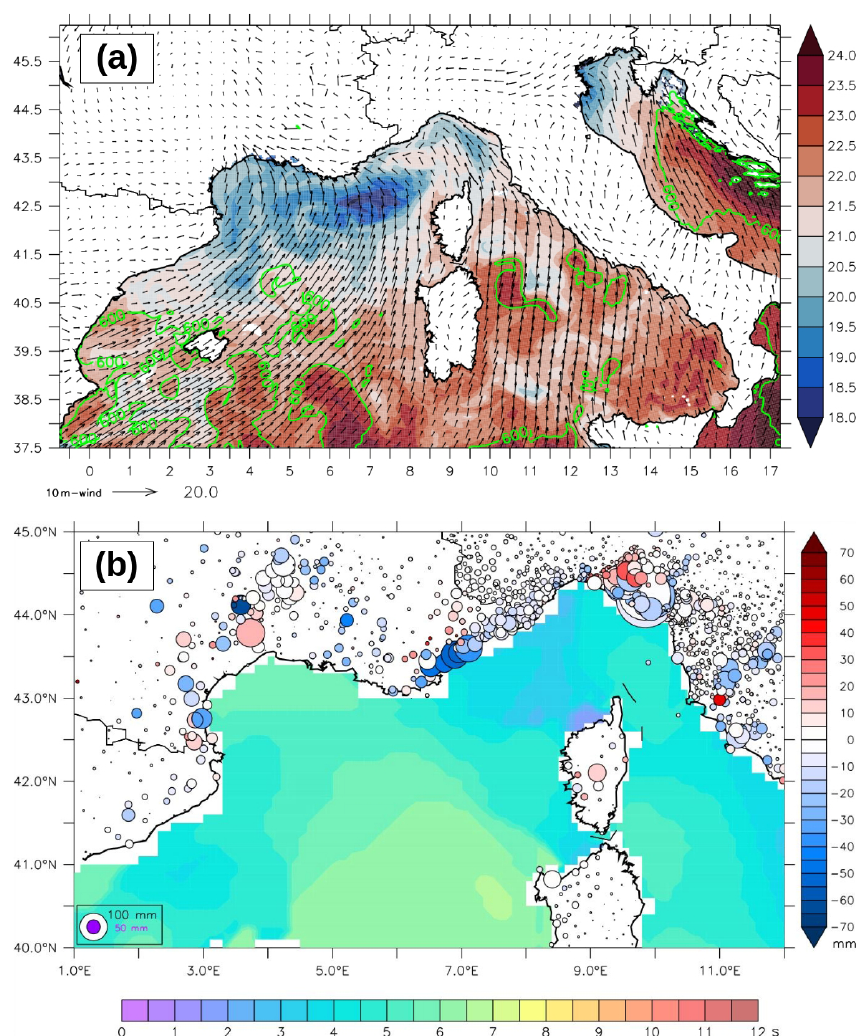
Figure 5. (a) Daily mean SST (colors, ◦ C), 10m wind (arrows, ms − 1 ), and surface evaporation (green contours for values above 600kgm − 2 ) for 26 October 2012 (IOP16a) from the AROME–NEMO WMED coupled experiment (CPLOA) of Rainaud et al. (2017). (b) Peak period of waves (color, s) at 00:00UTC on 26 October 2012 considered in Thévenot et al. (2016) and bias modification (circles,mm) for 24h rainfall accumulation against rain gauge data, comparing Meso-NH simulations with (WAM) and without (NOWAV) sea state impact (blue for an improvement in WAM). The size of the circles indicates the NOWAV bias (absolute value,